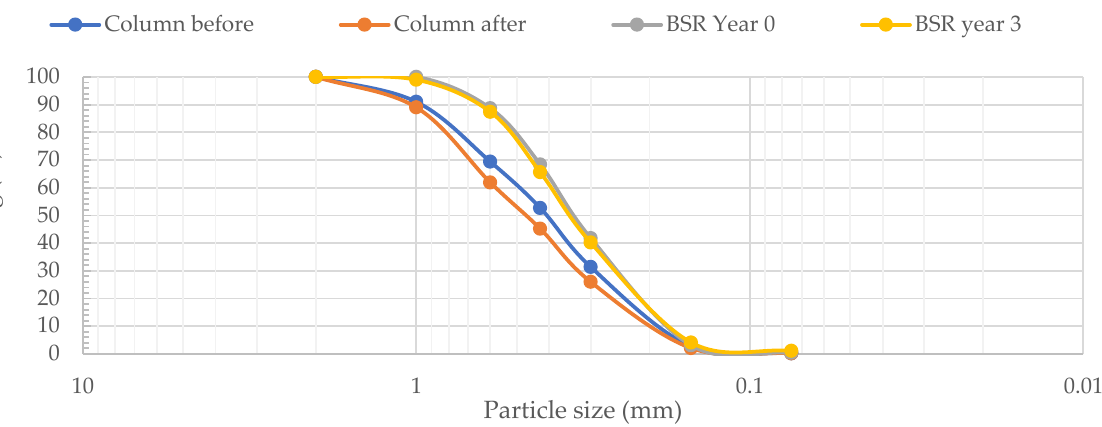
Figure 9. Particle size distribution curves for the batches of sand used in the column 2 experiments and the biological sand reactors at the beginning and end of the respective experimental periods.